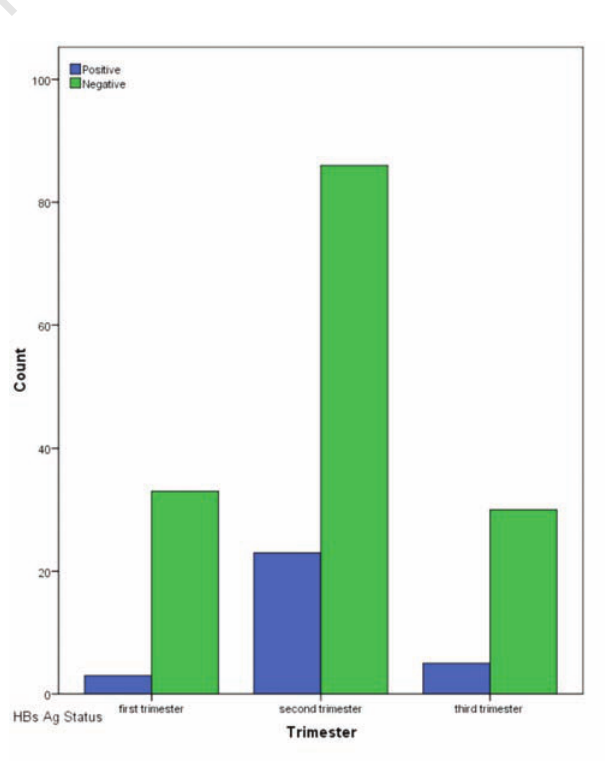
Figure 3. Occupational distribution of hepatitis B surface antigen among pregnant women.